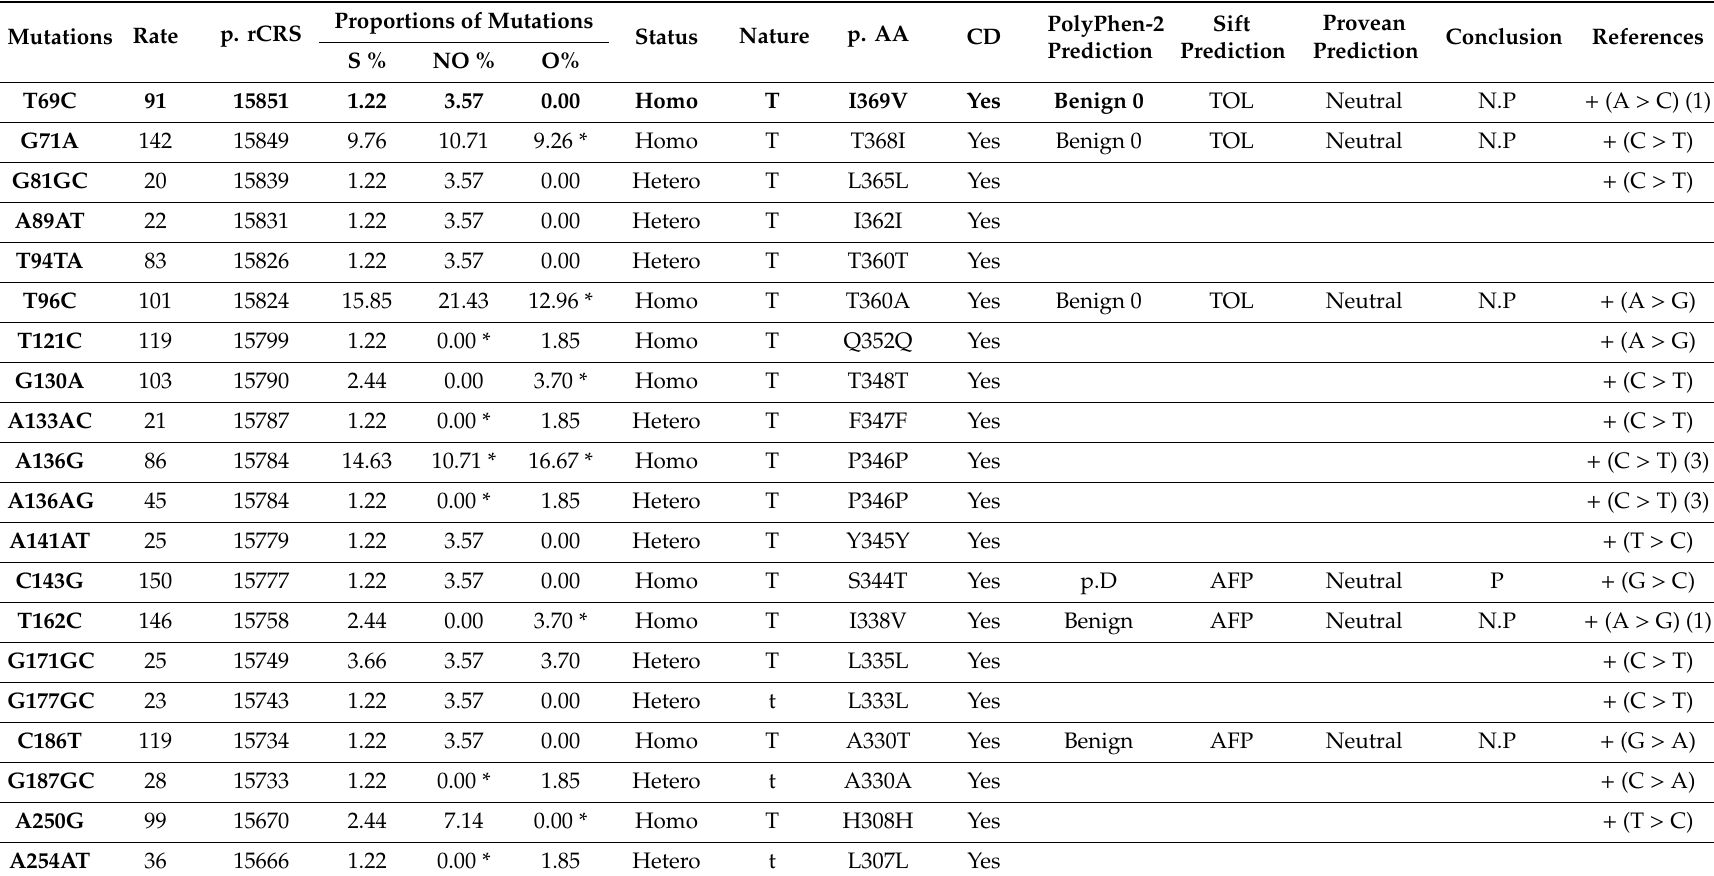
Table 1. Characteristics of MT-CYB